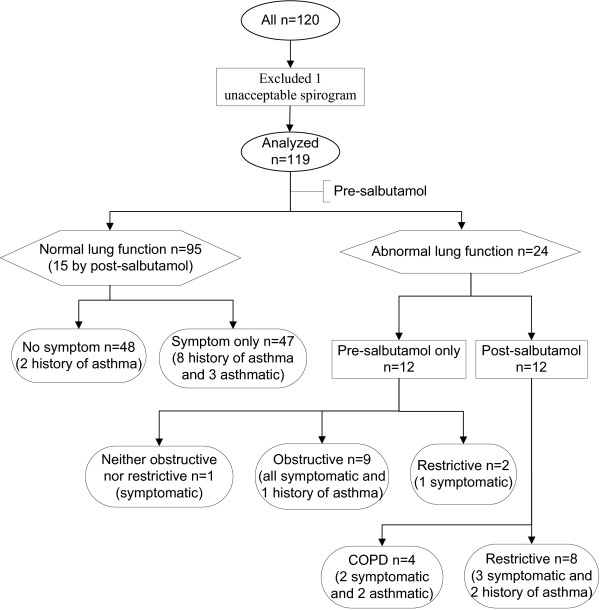
Study flow chart and subject classifications. Normal lung function was defined by FEV1/FVC ≥ 70% and %FEV1 ≥ 80% and %FVC ≥ 80%, by both pre- and post-salbutamol tests. Pre-salbutamol values were used to classify normal lung function if post-salbutamol test was not done. Abnormal lung function was defined by either FEV1/FVC < 70% or %FEV1 < 80% or %FVC < 80%, either pre- or post-salbutamol test. Symptomatic was defined as having cough, sputum or breathlessness. Obstructive lung function was classified as pre-salbutamol FEV1/FVC < 70% without post-salbutamol values. COPD was defined as post-salbutamol FEV1/FVC < 70%. Restrictive lung function was defined by FEV1/FVC ≥ 70% and %FVC < 80%, either before or after salbutamol inhalation. Asthma was defined as reversible FEV1, which improved more than 12% and 200 ml after salbutamol inhalation.